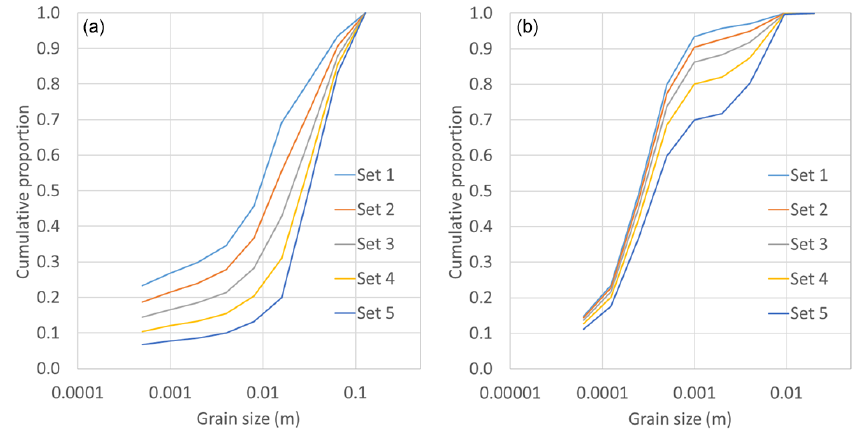
Figure 2. Sediment grain size distribution sets for the Upper Swale (a) and Tin Camp Creek (b) , showing the cumulative proportions.